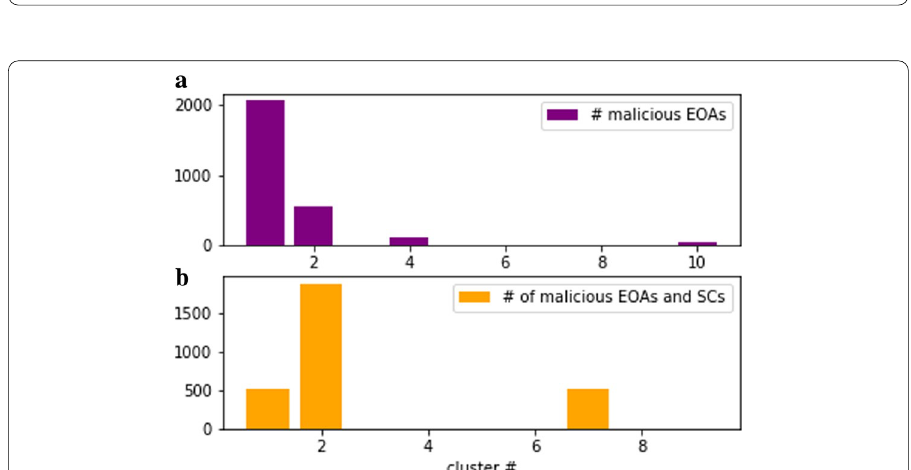
Fig. 11 Clusters with number of malicious accounts for a when only EOAs are considered, b when both EOAs and SCs are considered